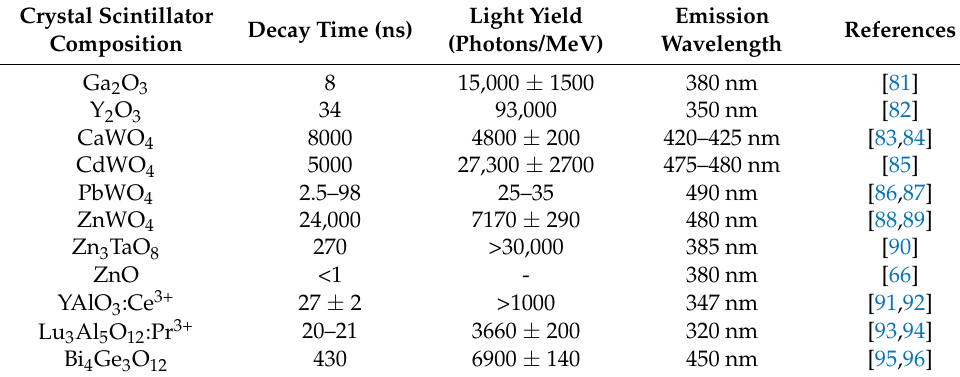
Table 2. A list of oxides and their scintillation characteristics. Crystal